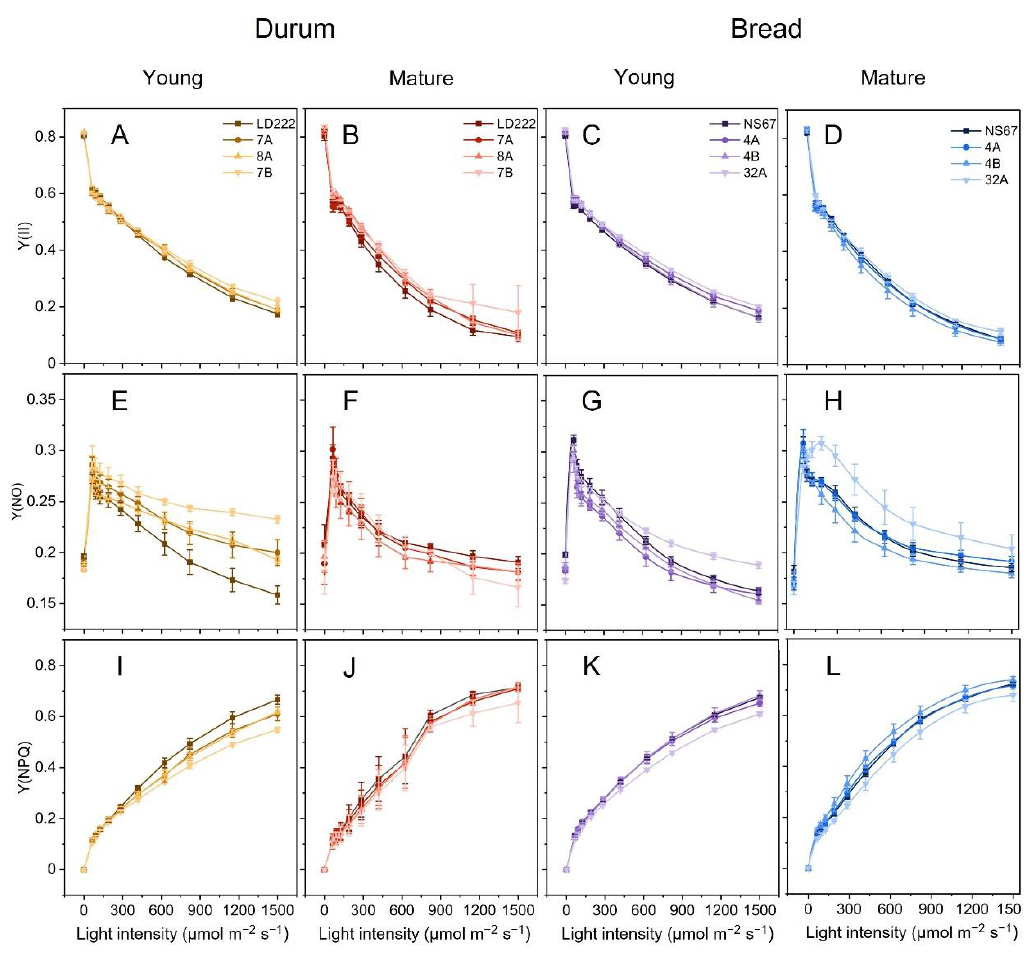
Figure 2. Long-term light-acclimation features of photosynthesis in young and mature bread-wheat plants. Light-response curves relative to: ( A – D ) actual quantum yield of PSII photochemistry Y(II), ( E – H ) quantum yield of constitutive, non-regulatory energy dissipation Y(NO), and ( I – L ) quantum yield of regulatory thermal dissipation Y(NPQ). The curves were recorded during 60 min of exposure to increasing actinic-light intensities. Average values ± Standard Deviation for n =